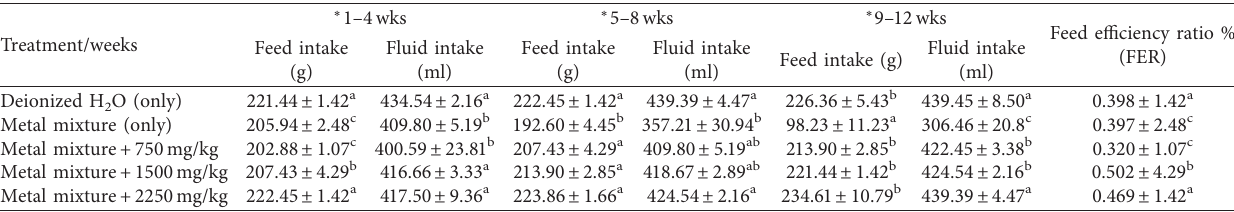
Table 1: Effect of Costus afer on the feed intake (g) and fluid intake (ml) and food efficiency ratio (%) of male albino rats treated with metal